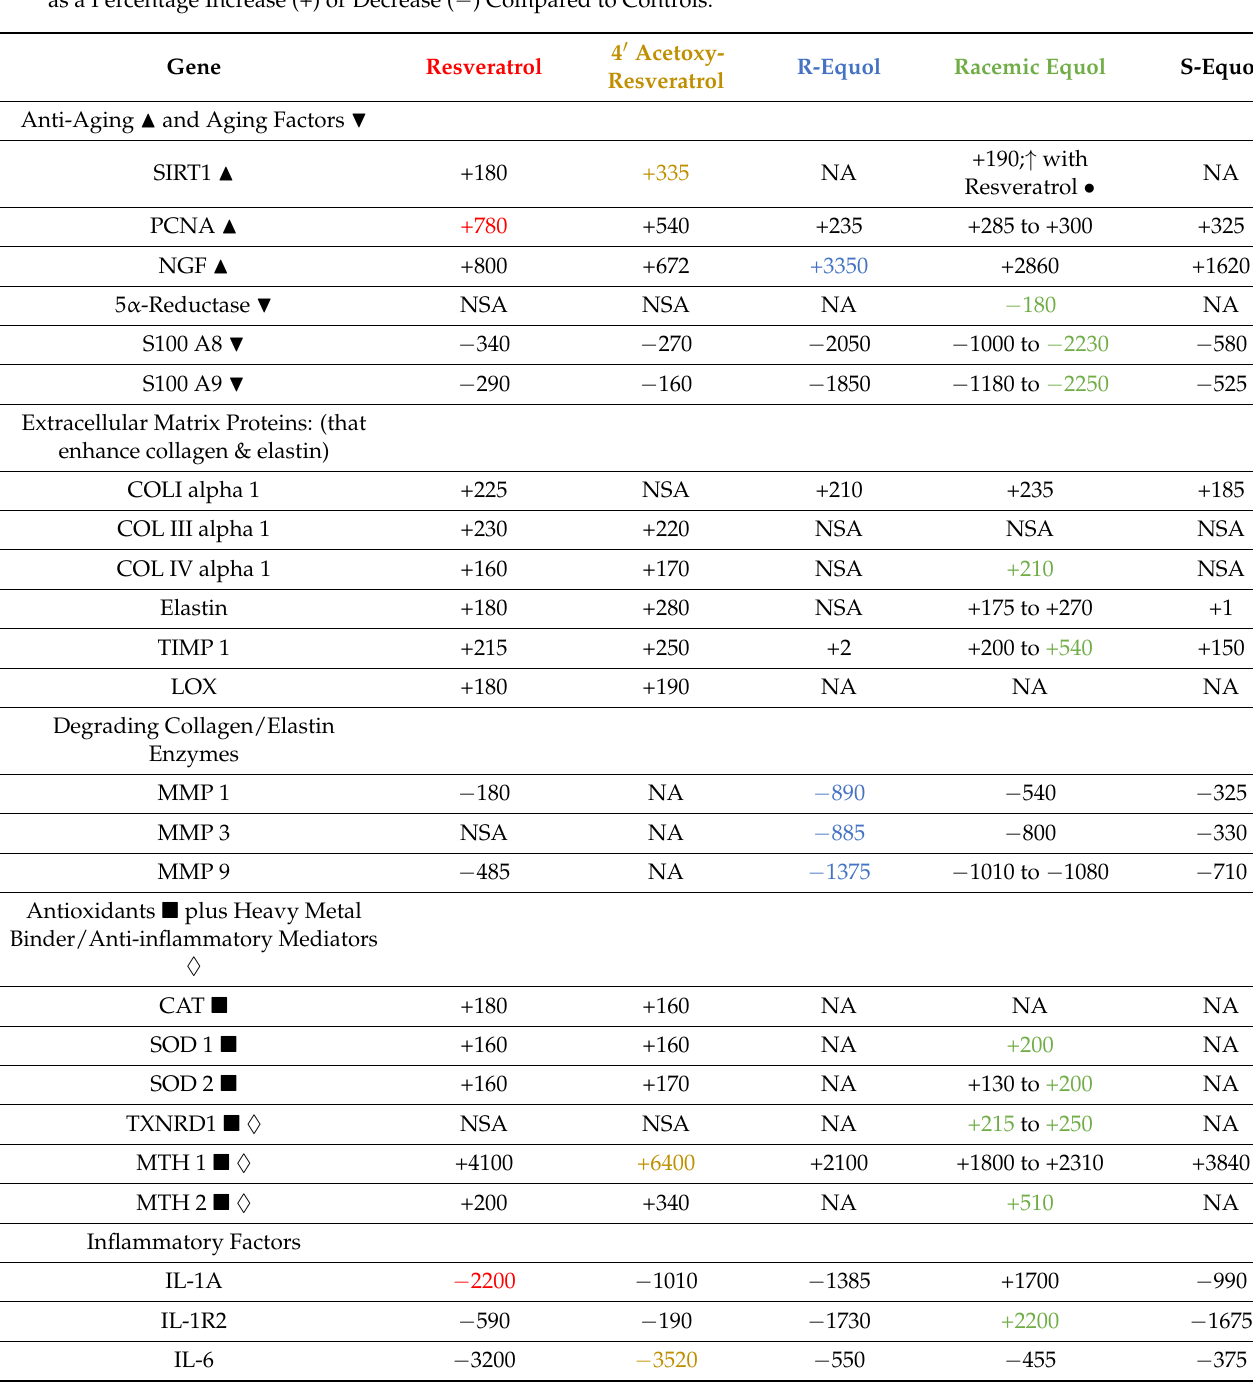
Table 1. Human Skin Gene Expression Among Resveratrol, 4 (cid:48) Acetoxy-Resveratrol, R-Equol, Racemic Equol and S-Equol. as a Percentage Increase (+) or Decrease ( − ) Compared to